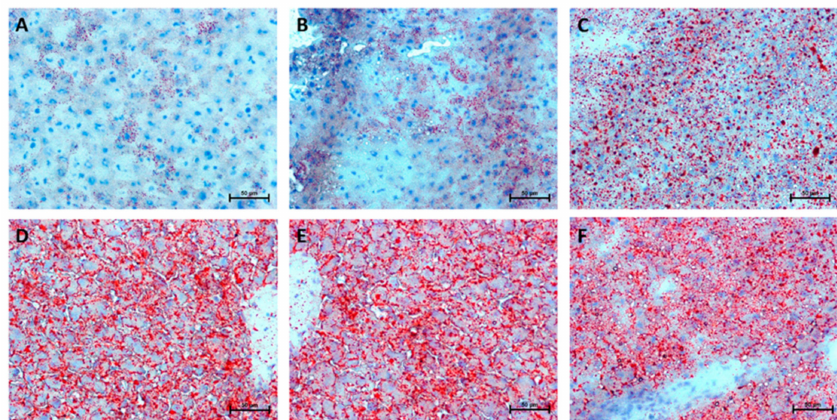
Figure 9. Representative histological images of the liver sections showing lipid droplets accumulation stained by Oil Red O from control group (0 week, A ) and HFD group at the end of the first ( B ), second ( C ), third ( D ), fourth ( E ) and fifth ( F ) experimental week. The data are based on six independent determinations ( n = 6) of the same fragment of the lobe from each rat. Original magnification of 200 × and the length of the calibration bar is 50 µ m.